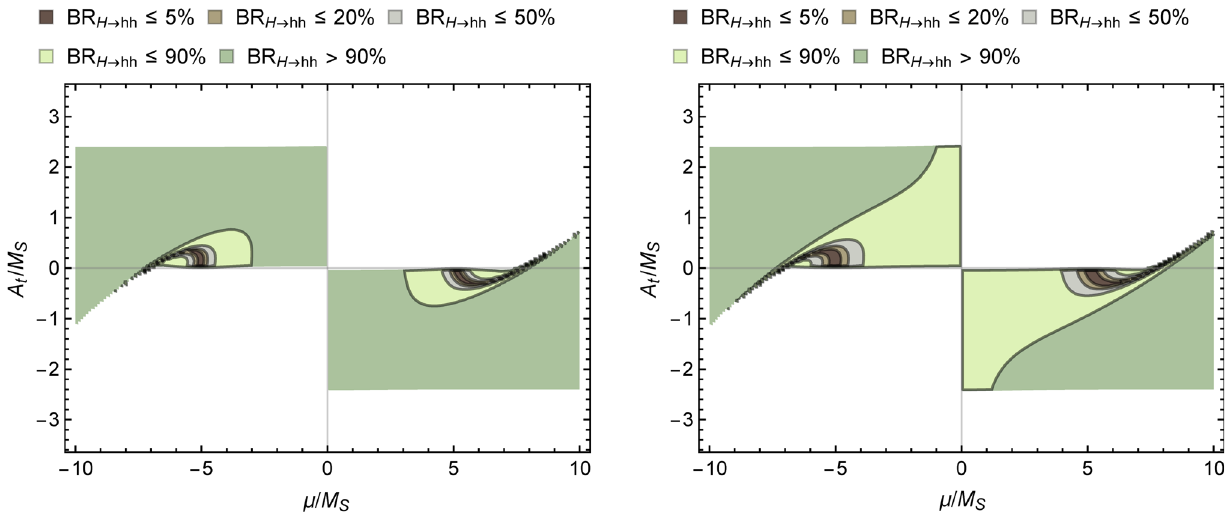
the two-loop improved result here, and we assume the light Higgs mass to be M h = 10 GeV (left) and 60 GeV